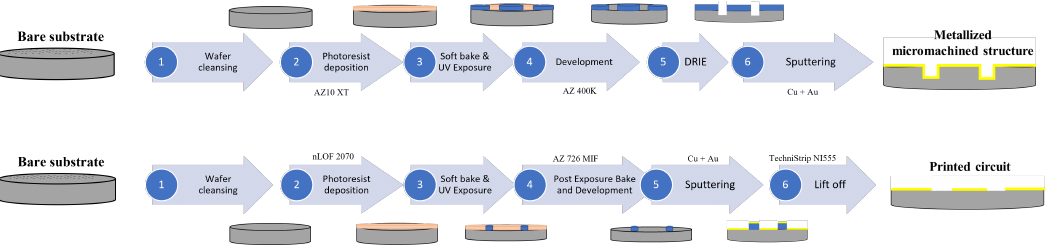
Figure 13. Diagram of the fabrication process followed in this work. Top : Fabrication of the AMC structure. Bottom : Fabrication of the coplanar